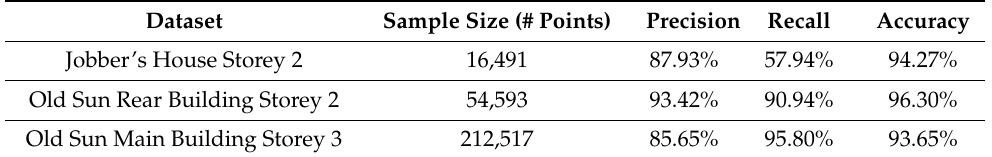
Table 1. Storey separation results.